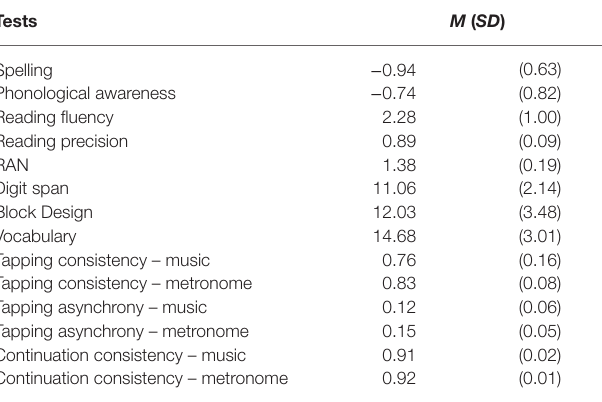
TABLE 1 | Descriptive statistics for all observed